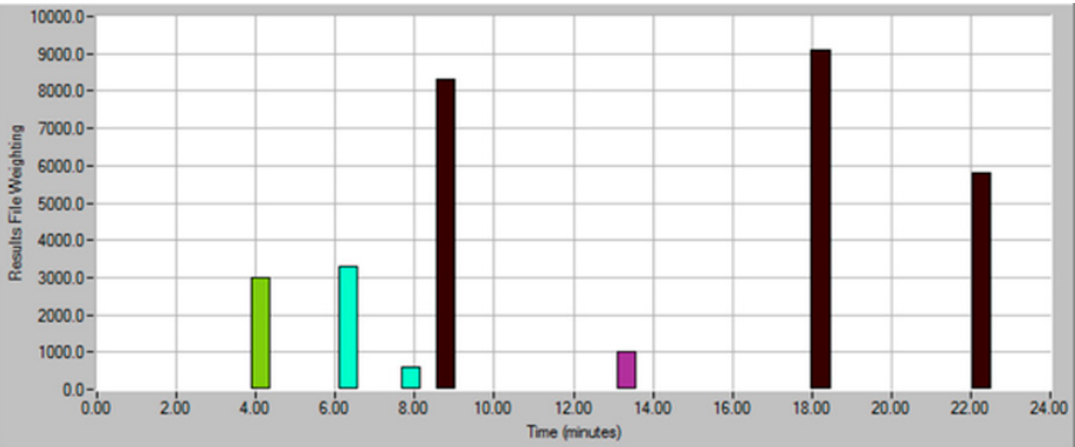
Figure 7. Aroma dilution analysis plot of wine made from Frontenac grapes harvested at 24° Brix. The compounds most impactful in the total aroma of this sample occurred at: (1) 18.0 min, assigned odor dilution number 8; (2) 22.3 min, assigned odor dilution number 8; (3) 8.6 min, assigned odor dilution number 4; and (4) 6.3 min, assigned odor dilution number 4, while simultaneously identified using a mass spectrometer as: (1) ethyl octanoate; (2) ethyl decanoate; (3) 1-pentanol; and (4) ethyl isobutyrate.